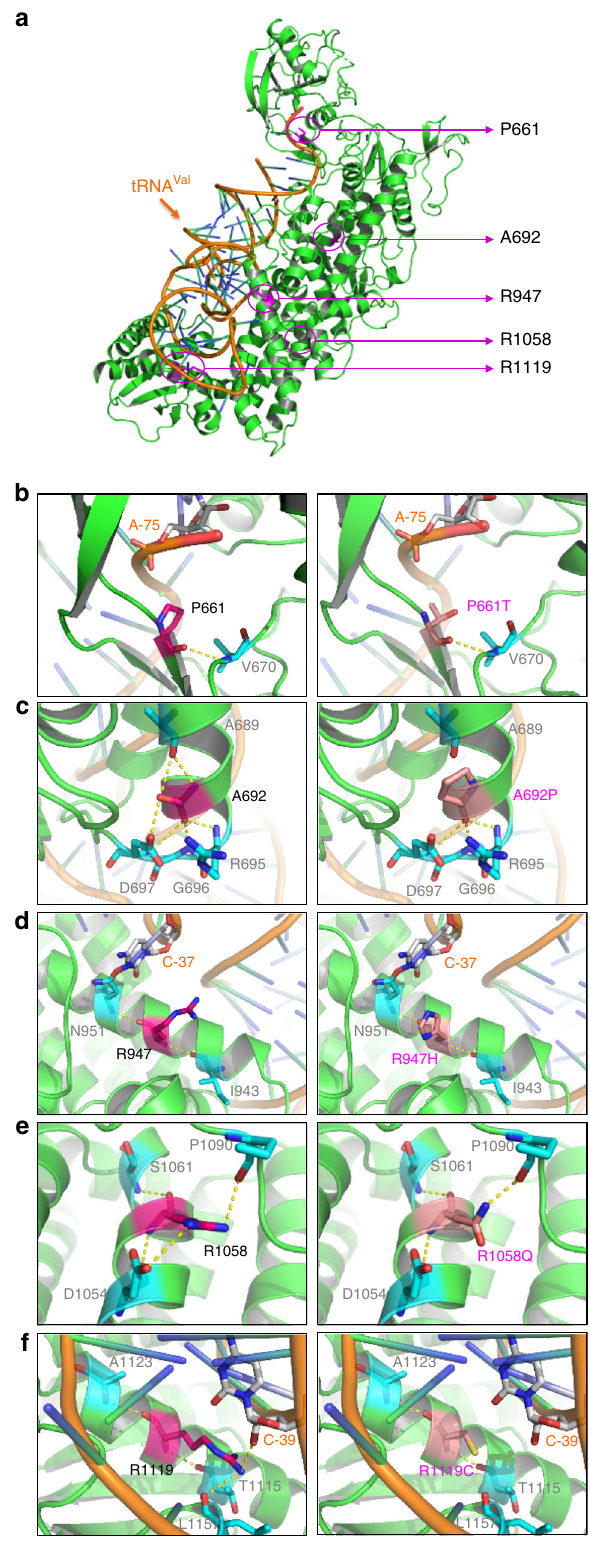
Fig. 2 Predicted mutational impact on VARS structure and tRNA binding. a Locations of the mutational sites on the structural model of human VARS- tRNA Val complex (VARS green, tRNA Val orange, mutational sites magenta). Residues Pro661, Arg947, and Arg1119 are closer to the tRNA molecule (<6 Å), while Ala692 and Arg1058 have a longer distance of >15 Å from tRNA. b – f Pair-wise comparisons between the wild-type (left) and mutant (right) residues for predicted changes in local contacts with tRNA or other amino acids. Amino acids are indicated by letter and number (e.g., Pro661), tRNA bases are indicated by letter and dash and number (e.g., A-75). Hydrogen bonds are presented as yellow dashed lines. b Residue Pro661 forms a hydrogen bond with Val670 and has a distance of ~4.5 Å from A-75 of the tRNA. c Residue Ala692 forms hydrogen bonds with adjacent residues Ala689, Arg695, Gln696, and Asp697. Mutation to proline predicts abolished contacts with Ala689 and disrupted helical structure. d Residue Arg947 is close to C-37 and predicts hydrogen-bonding interaction that is abolished by the Arg947H mutation. This mutation does not predict altered hydrogen-bonding with Ile943 and Asn951. e Residue Arg1058 forms hydrogen bonds with Asp1054, Ser1061 and Pro1090. The NM_006295.2: c.3173G>A p.(Arg1058Gln) mutation predicts elimination one of the two possible bonds with Asp1054. f The side chain of Arg1119 forms a